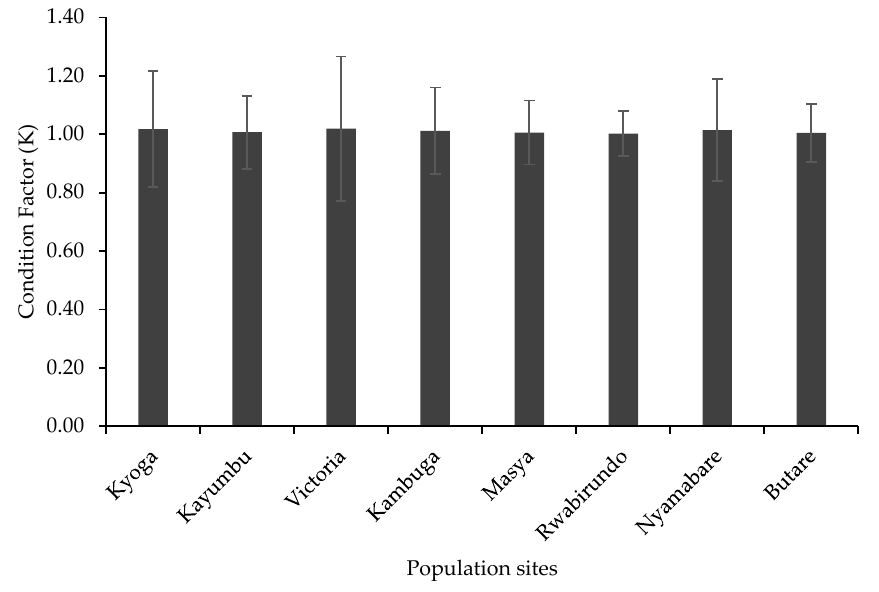
Figure 4. Relative condition factor of the different populations.